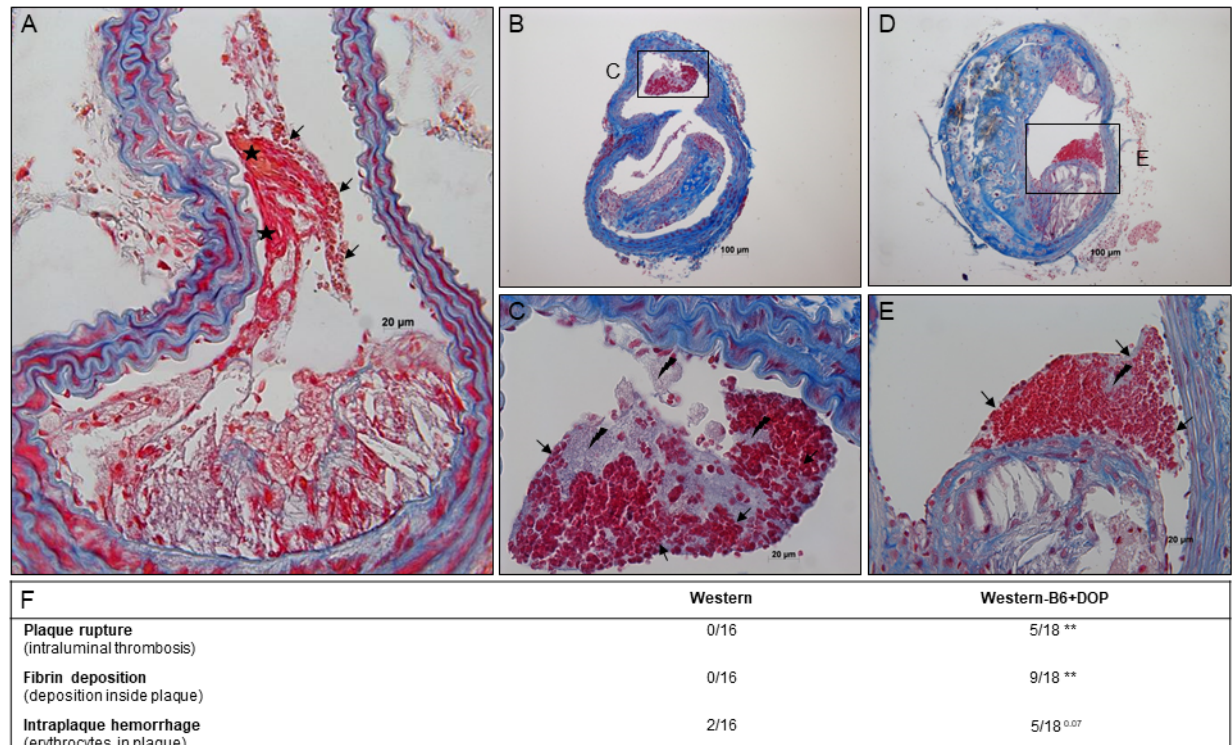
Figure 4. Plaque rupture and intraluminal thrombosis in DOP-treated ApoE − / − mice: representative findings and quantitation. ( A – E ) Representative BCA lesions from ApoE − / − mice on Western-B6+DOP for 12 weeks stained with Carstairs featuring different types of plaque rupture and thrombosis. ( A ) Fibrous cap break into the lumen with appositional thrombus consisting of erythrocytes ( → ) and fibrin ( ∗ ) that protrudes into the lumen (thrombus extends several hundred µ m up and downstream of the rupture site). ( B – E ) Further examples of plaque rupture and intraluminal thrombosis associated with individual plaque structures, thrombus containing erythrocytes ( → ) and platelets (flash sign); ( C ) and ( E ) are insets from ( B , D ) at a higher magnification. Magnification 400 × ( A ); 200 × ( B ); 600 × ( C ); 100 × ( D ); 400 × ( E ). ( F ) The groups were compared with a chi-square test. Plaque rupture (chi-square 9.874, p = 0.0072); fibrin deposition (chi-square 11.43, p = 0.0033); intraplaque hemorrhage (chi-square 5.349, p = 0.0689); ** p <